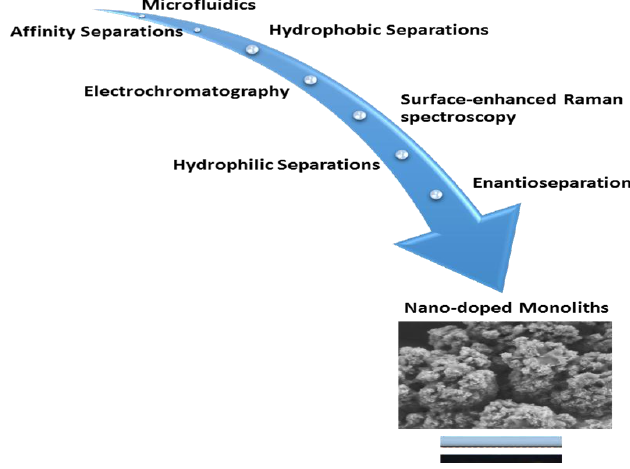
Figure 3. Selected applications of nano-doped monoliths.